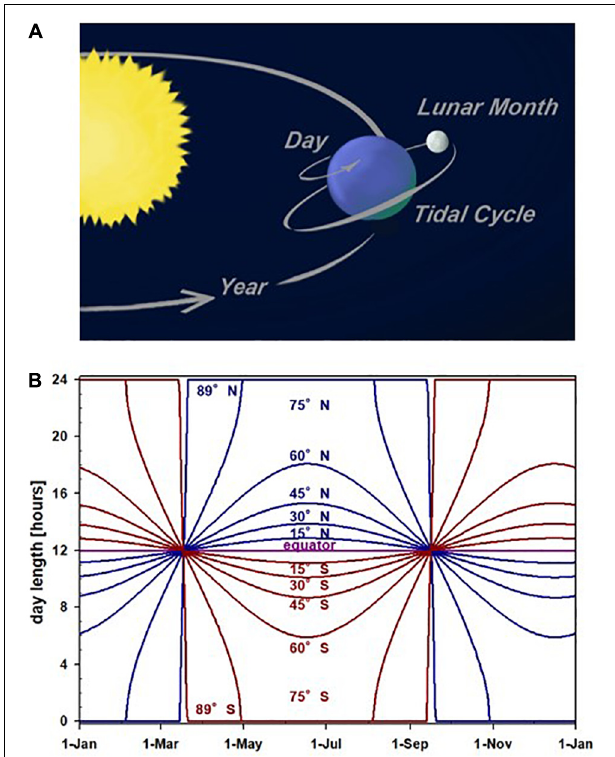
FIGURE 1 | Geophysical basis of periodic migrations. (A) Periodicities arising from planetary movements include annual cycles, diel cycles, and variants of lunar and tidal cycles; image: Edda Starck. (B) Daylength (photoperiod) changes across the year at different latitudes. Daylength changes are locally predictably, but only for organisms that remain at the same